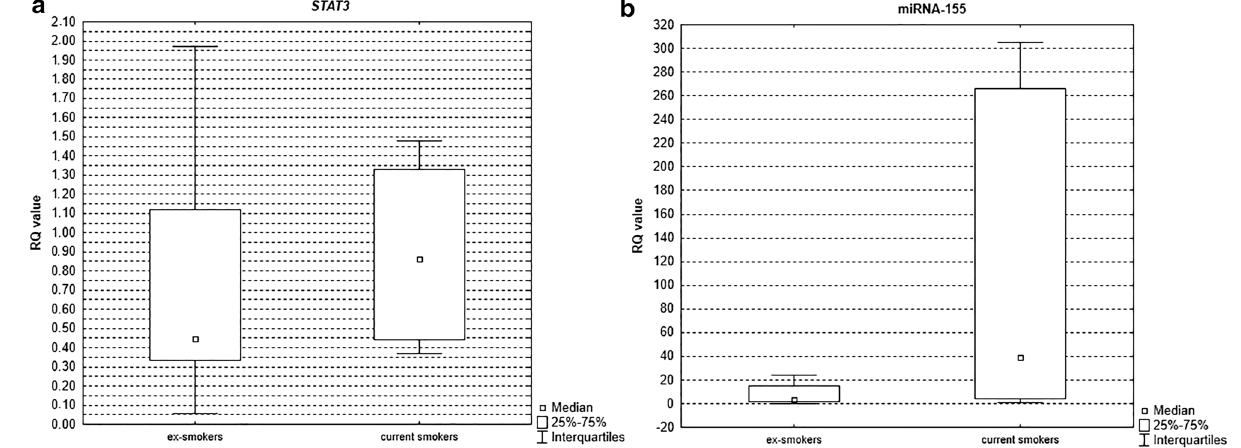
Figure 3. Box-and-whisker plots representing the expression value (median RQ value) of ( a ) STAT3 ( p = 0.04) ( b ) miRNA-155 ( p = 0.03) in COPD patients according to the actual smoking status in induced